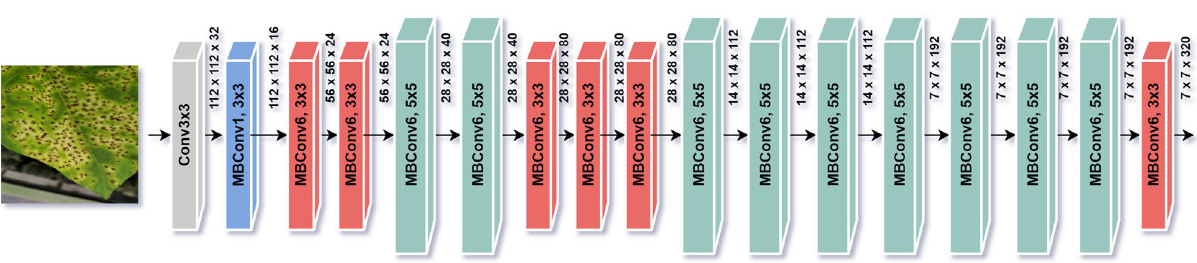
Figure 7. EfficientNet basic architecture with a sample input image and 18 convolution layers.